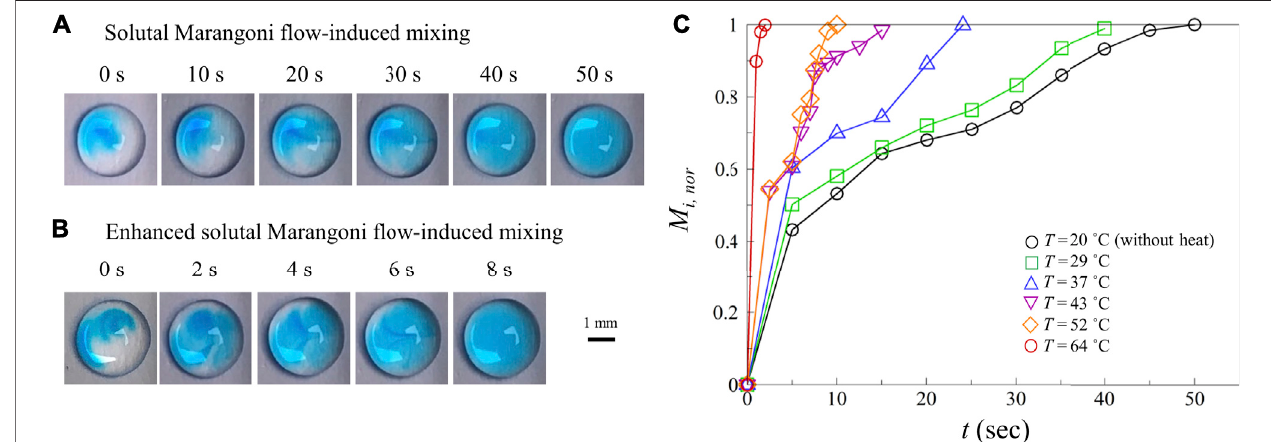
FIGURE 6 | (A) Droplet mixing images at each time by solutal Marangoni fl ow. (B) Droplet mixing images at each time by enhanced solutal Marangoni fl ow. (C) Mixing index-mixing time increasing pro fi le of volatile liquid